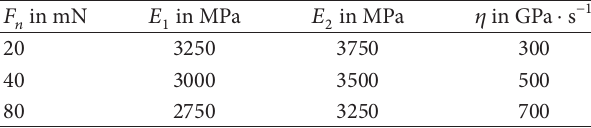
Table 2: Parameters of the Kelvin-Voigt viscoelastic model.